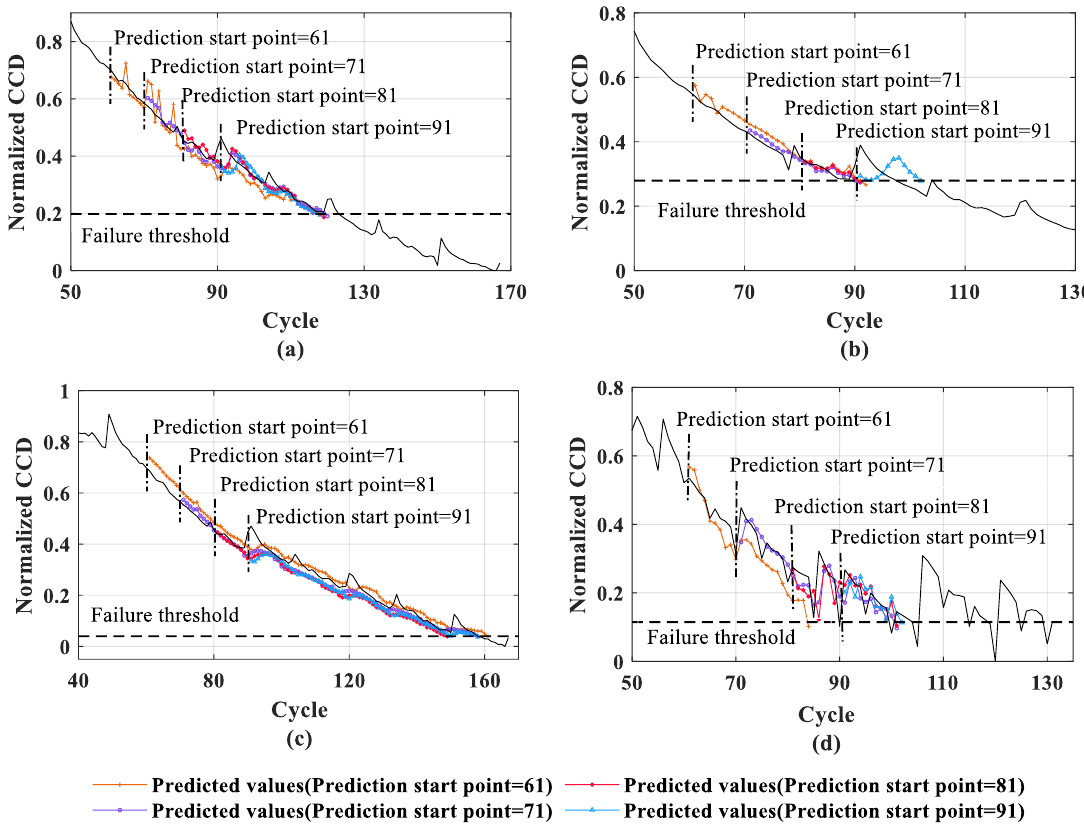
Figure 5. The prediction result of CCD with different prediction starting point for batteries: ( a ) B5, ( b ) B6, ( c ) B7, ( d ) B18. Table 4. The obtained results with different prediction start points for B6. Battery